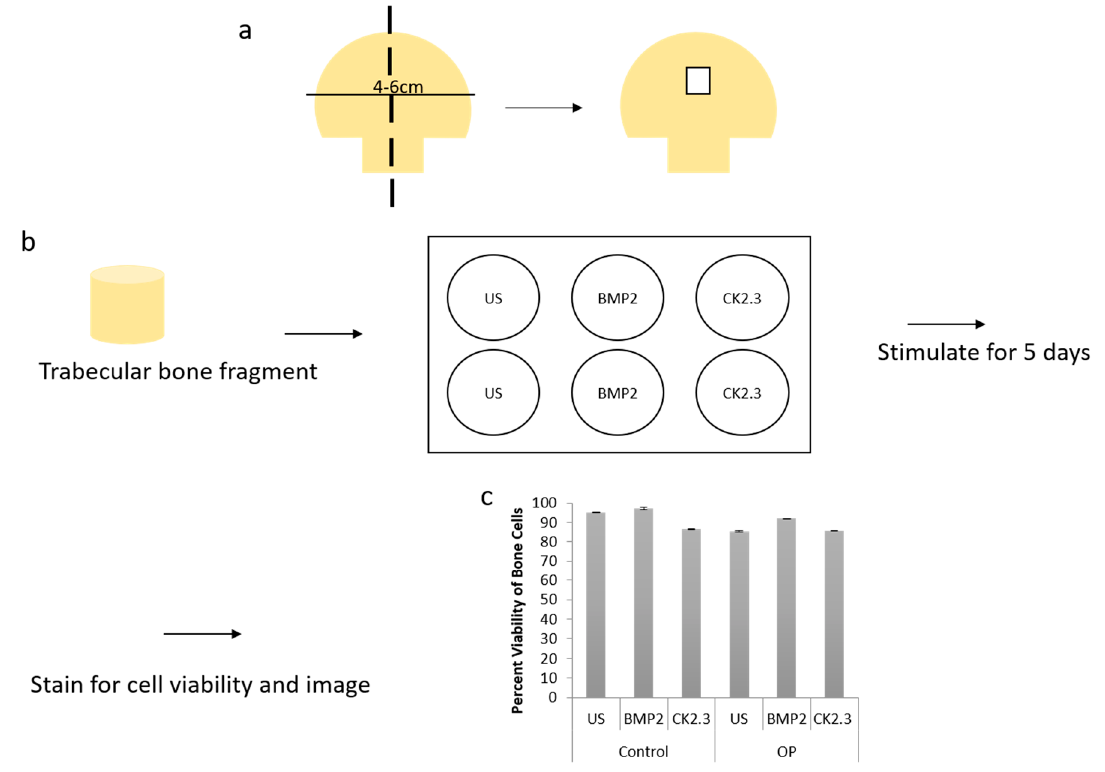
Figure 3. ( a ) A schematic representing how femoral heads were sliced down the midsagittal plane, and what region of interest was used for both the methyl methacrylate (MMA) experiments and the explant experiments. ( b ) Diagram showing the explant experimental set up. The trabecular bone fragment was removed from the femoral head, washed with PBS incubated with antibiotics/antimycotics for 10 min. The fragments were placed in a six well plate (one fragment per well) with DMEM. They were stimulated as designated for five days, following which they were either stained for cell viability and imaged or they were fixed with 4.4% PFA, immunofluorescently stained and then imaged. ( c ) Cell viability was assessed through a Calcein and Hoescht stain, and viable cells were counted. Under all stimulations and conditions cells were 80% or more viable within the explants. Error bars represent standard error of the mean (SEM).